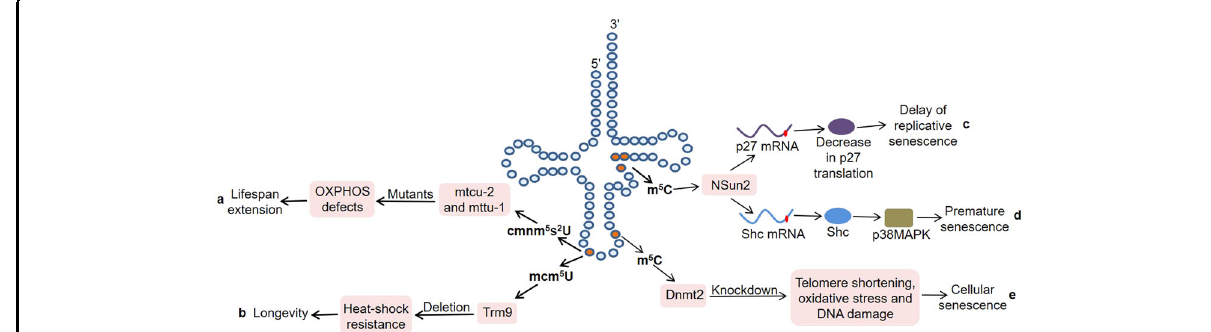
Fig. 2 The dysregulation of tRNA-modifying enzymes in aging and lifespan. a The mtcu-2 and mttu-1 mutants show OXPHOS dysfunction, resulting in lifespan extension. b Trm9 deletion enhances heat-shock resistance of mutants, thereby supporting the link between longevity and cellular protection. c NSun2 inhibits the translation of p27 by methylating p27 mRNA, thereby delaying the process of replicative senescence. d NSun2 promotes the translation of Shc adapter proteins by methylating Shc mRNA. Subsequently, the increased Shc proteins activate p38MAPK, thereby facilitating premature senescence. e Dnmt2 knockdown fi broblasts are susceptible to senescence under control conditions, manifested by telomere shortening, oxidative stress, and DNA